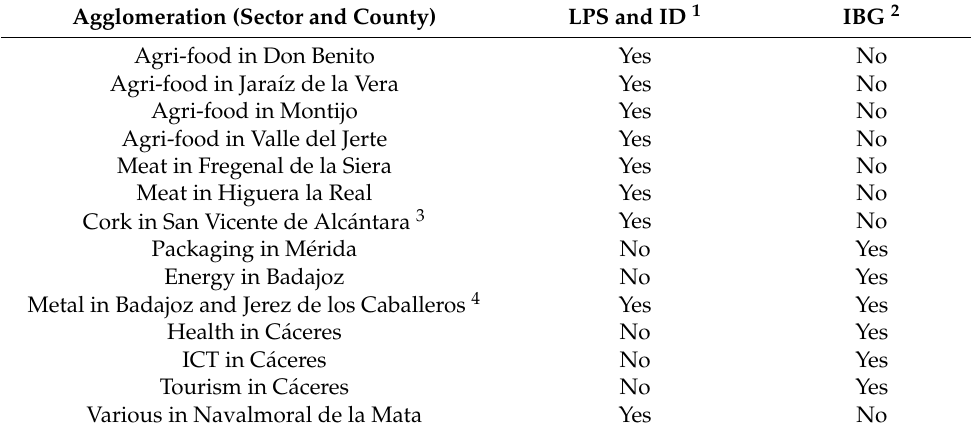
Table 1. Business agglomerations vs. innovative business groups (IBGs) listed in Extremadura, 2013. Agglomeration (Sector and